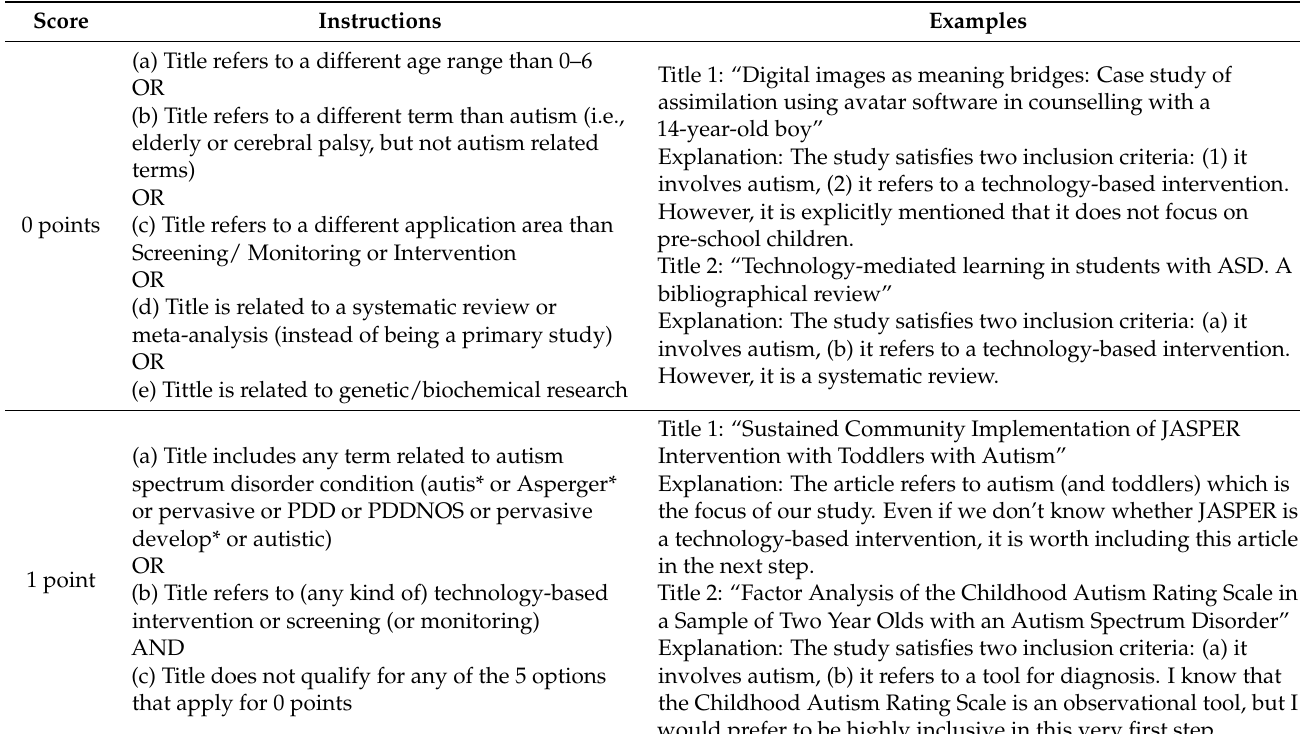
Table A5. Instructions for titles